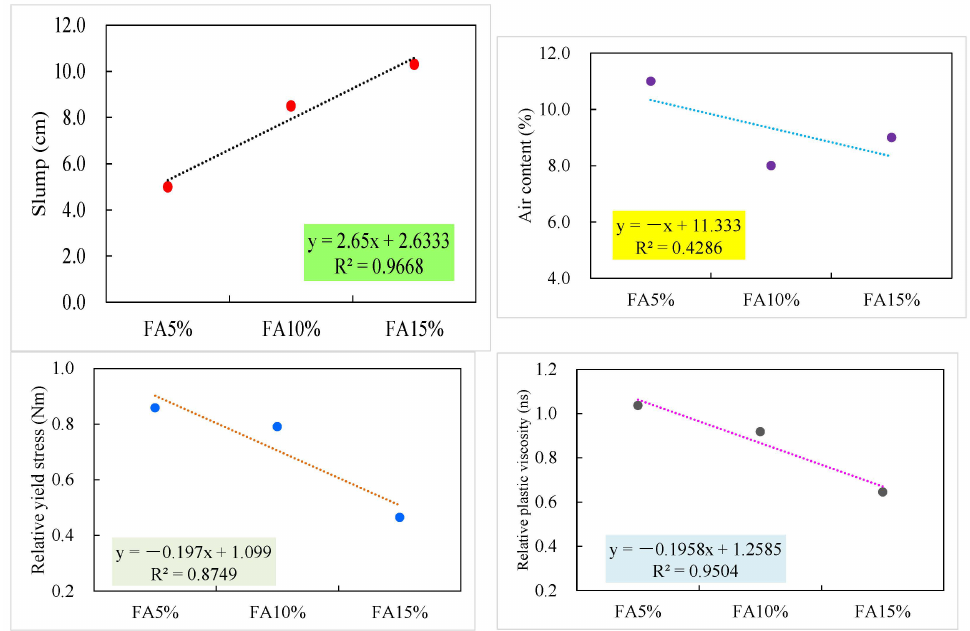
Figure 14. Effect of fly ash on slump, air content, relative yield stress, and viscosity.